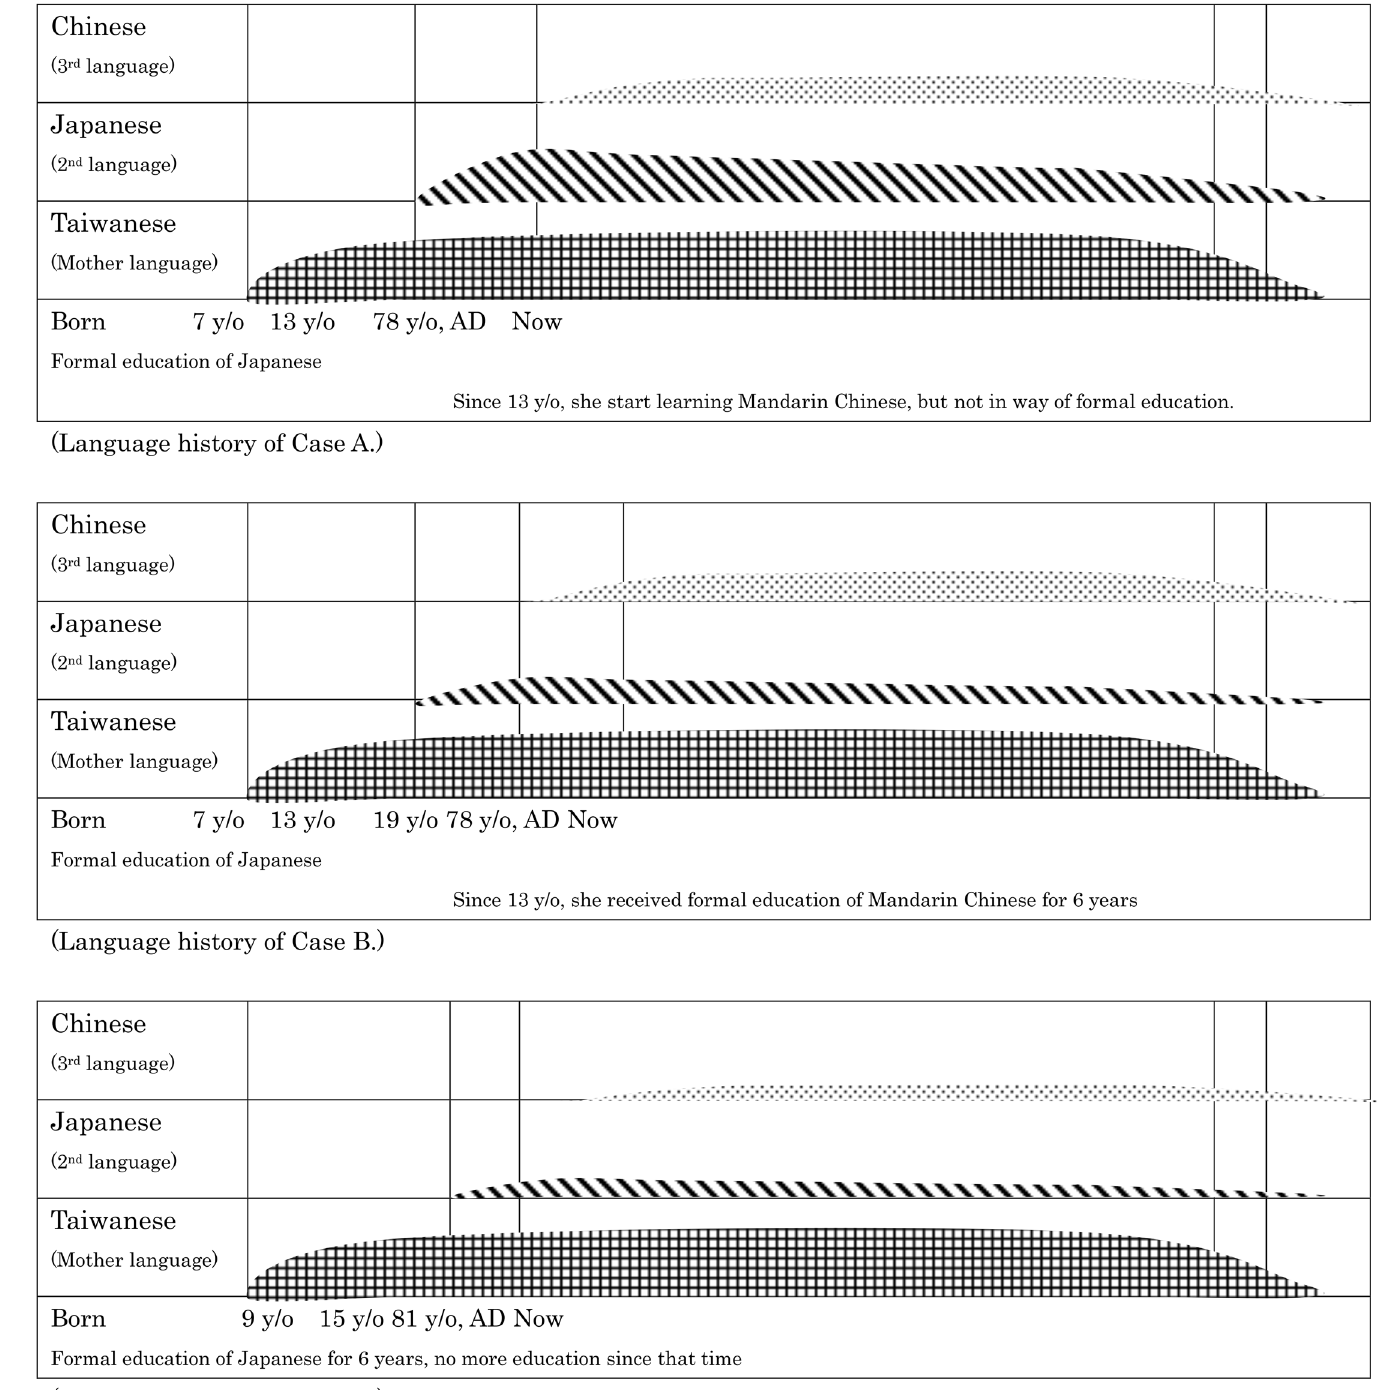
Fig 3. Asymmetric language degeneration in our multilingual subjects. Multilingual subjects received formal education in Japanese for at least 6 years and Mandarin Chinese with variable courses. During the progression of dementia, impaired language ability was apparent in each language. However, their language ability was not equal at the outset. The result is a very asymmetric language presentation after dementia.